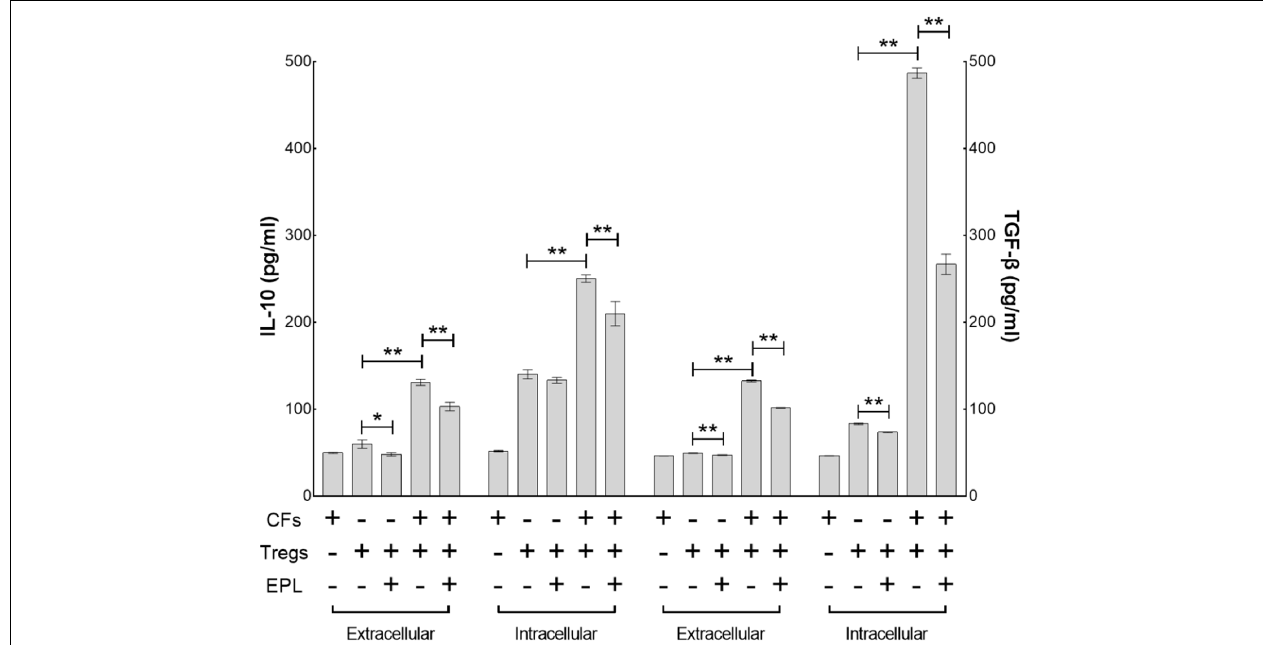
FIGURE 6 | Eplerenone primarily antagonizes the augmentation of intracellular TGF- β in Tregs co-cultured with CFs. ELISA assay demonstrates that co-culture of CFs with Tregs elevated the intracellular cytokines to a significantly higher degree than it did the extracellular cytokines after 48 h (Tregs + CFs vs. Tregs, n = 8, P < 0.01). Of the intracellular cytokines, TGF- β secretion (5.8-fold from 83.21 ± 0.82 to 486.85 ± 5.95) was elevated to a greater extent than IL-10 secretion (1.8-fold from 140.24 ± 5.30 to 250.42 ± 4.17), whereas there was no significant difference between the degree of elevation for the extracellular cytokines (2.7-fold from 49.54 ± 0.33 to 132.52 ± 1.08 for TGF- β and 2.2-fold from 59.98 ± 4.78 to 130.82 ± 3.54 for IL-10). Treatment with 30 µ M eplerenone was shown to suppress intracellular TGF- β levels (45.2% suppression from 486.85 ± 5.95 to 266.80 ± 11.76) to a greater extent than intracellular IL-10 levels (16.2% suppression 250.42 ± 4.17 to 209.91 ± 14.01), whereas the extent of suppression of the extracellular cytokines levels by eplerenone did not differ significantly (23.3% suppression from 132.52 ± 1.08 to 101.60 ± 0.41 for TGF- β and 21.2% suppression from 130.82 ± 3.54 to 103.02 ± 4.99 for IL-10) ( ∗ P < 0.05, ∗∗ P <